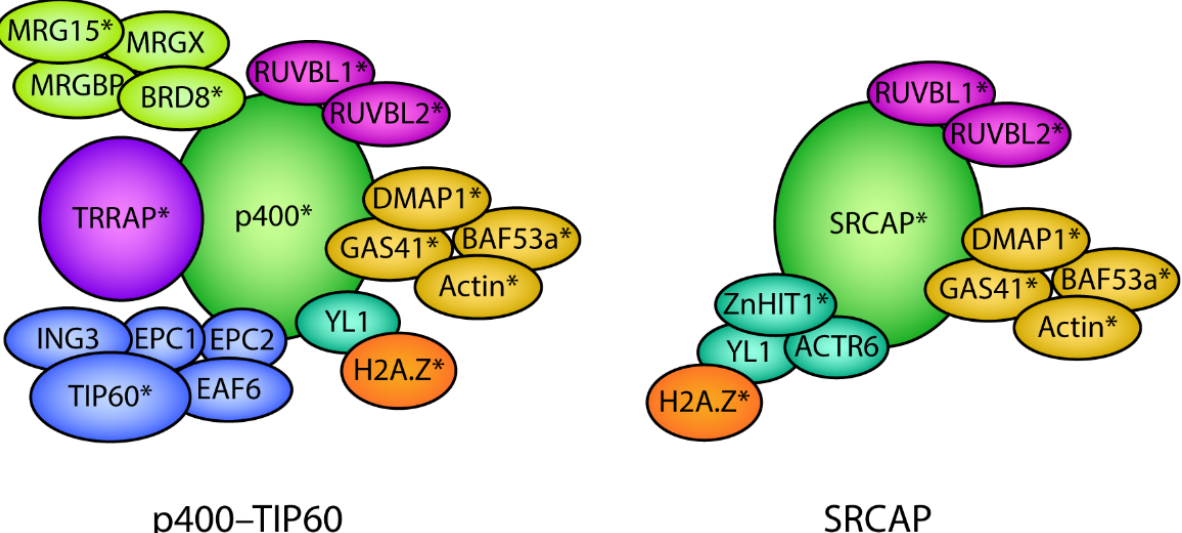
Figure 4. Protein subunit composition of the p400–TIP60 and SRCAP chromatin remodeling com- plexes . The p400–TIP60 and SRCAP complexes are composed of multiple protein subunits that are assembled into the complex as part of functional modules depicted by the different colors. Several subunits are shared between the p400/SRCAP and SRCAP complexes depicted by the same colors. H2A.Z associates with p400/TIP60 and SRCAP via the shared histone chaperone YL1. * denotes subunits that have been shown to play a direct role in development.